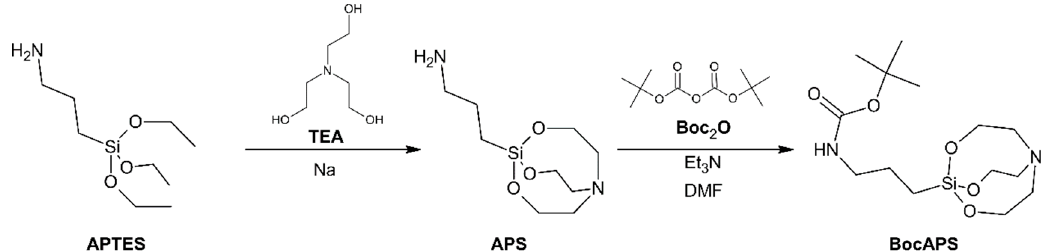
Figure 1. Synthesis of N- tert -butoxycarbonylaminopropylsilatrane (BocAPS).